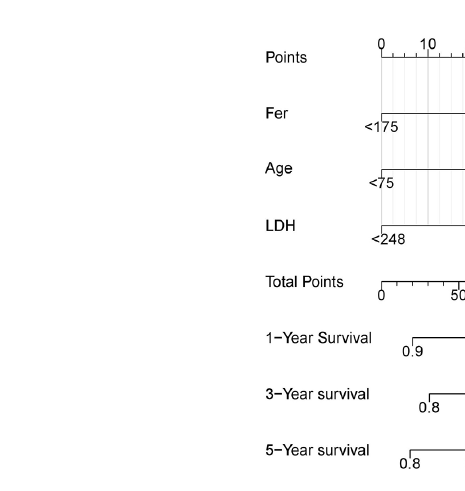
FIGURE 3 | Nomogram for patients with DLBCL. The patient's clinical eigenvalues are placed on each variable axis and a line is drawn upward to determine the number of points gained for each variable value. The sum of these numbers lies on the total point axis, and then a line is drawn down on the survival axis to determine his overall survival probability.